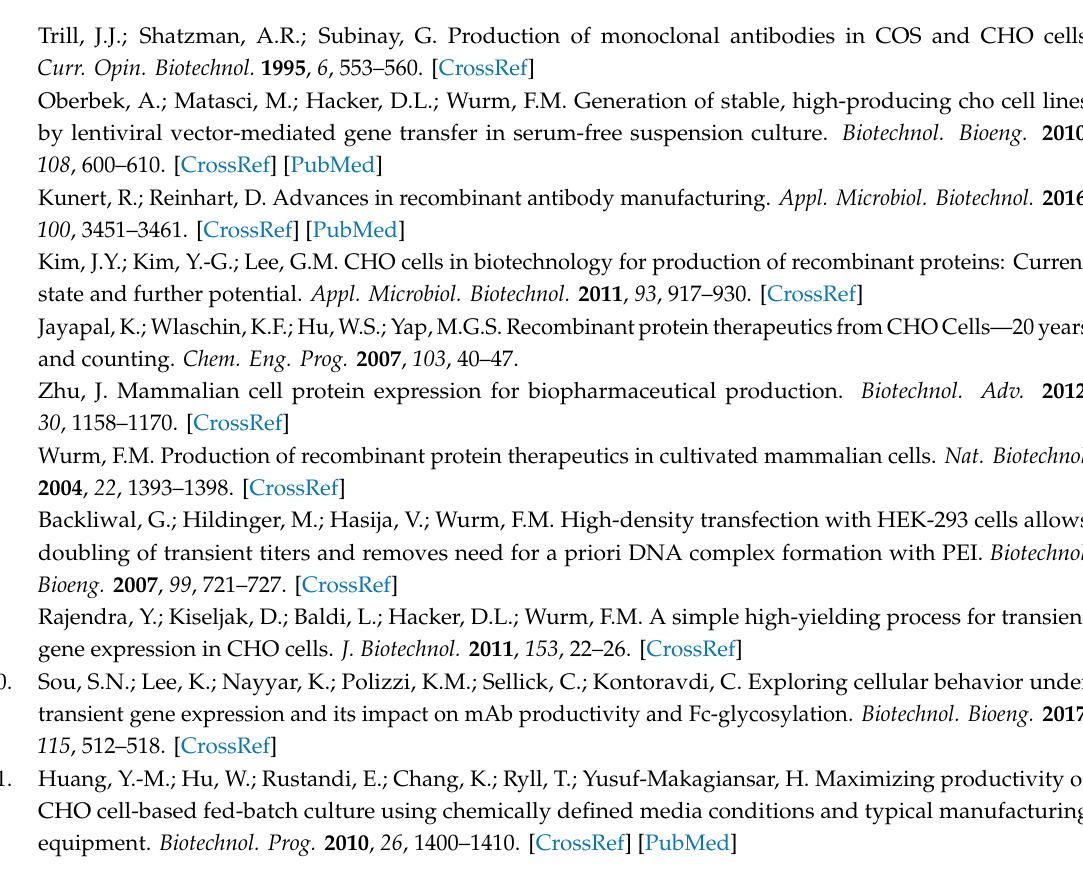
Figure S1: Schematic process block diagrams for large-scale mAb production (200 kg / year) by: ( a ) SGE and ( b ) CFPS; Figure S2: Schematic process block diagrams for small-scale mAb production (25 kg / year) by ( a ) TGE and ( b ) CFPS; Figure S3: Process flow for personalized medicine manufacturing process by CFPS; Figure S4: The e ff ect of DNA recovery on mAb COG, $ / person / year for the assumed mAb demand as 20 g mAb / person / year. (mAb COG = Raw material cost); Table S1: CFPS medium components; Table S2: Process Economic data for large-scale manufacturing via SGE and CFPS production route (200 kg mAb / year); Table S3: The operating cost per batch of 1 L CFPS reaction